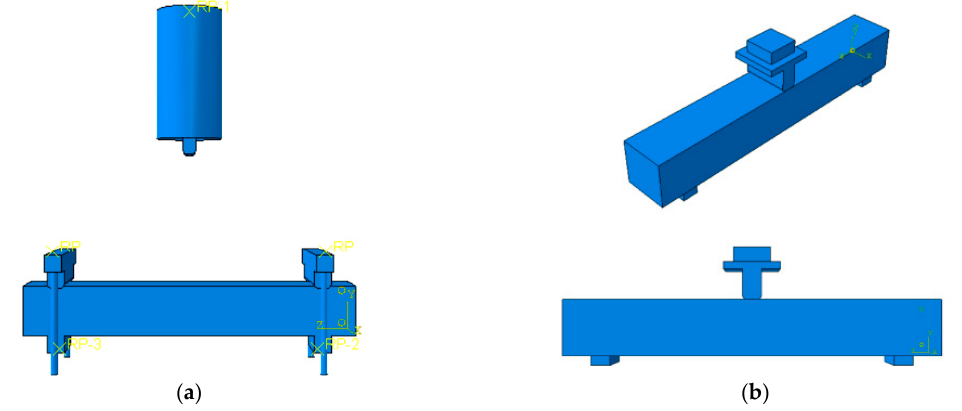
Figure 5. RC beam assembly simulations; ( a ) impact, ( b ) quasi-static.